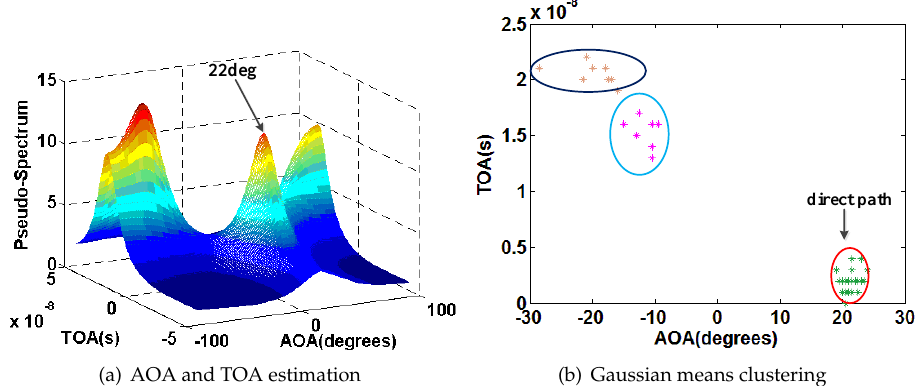
Figure 15. Results of AOA and TOA estimation and the related Gaussian means clustering at the AP1.